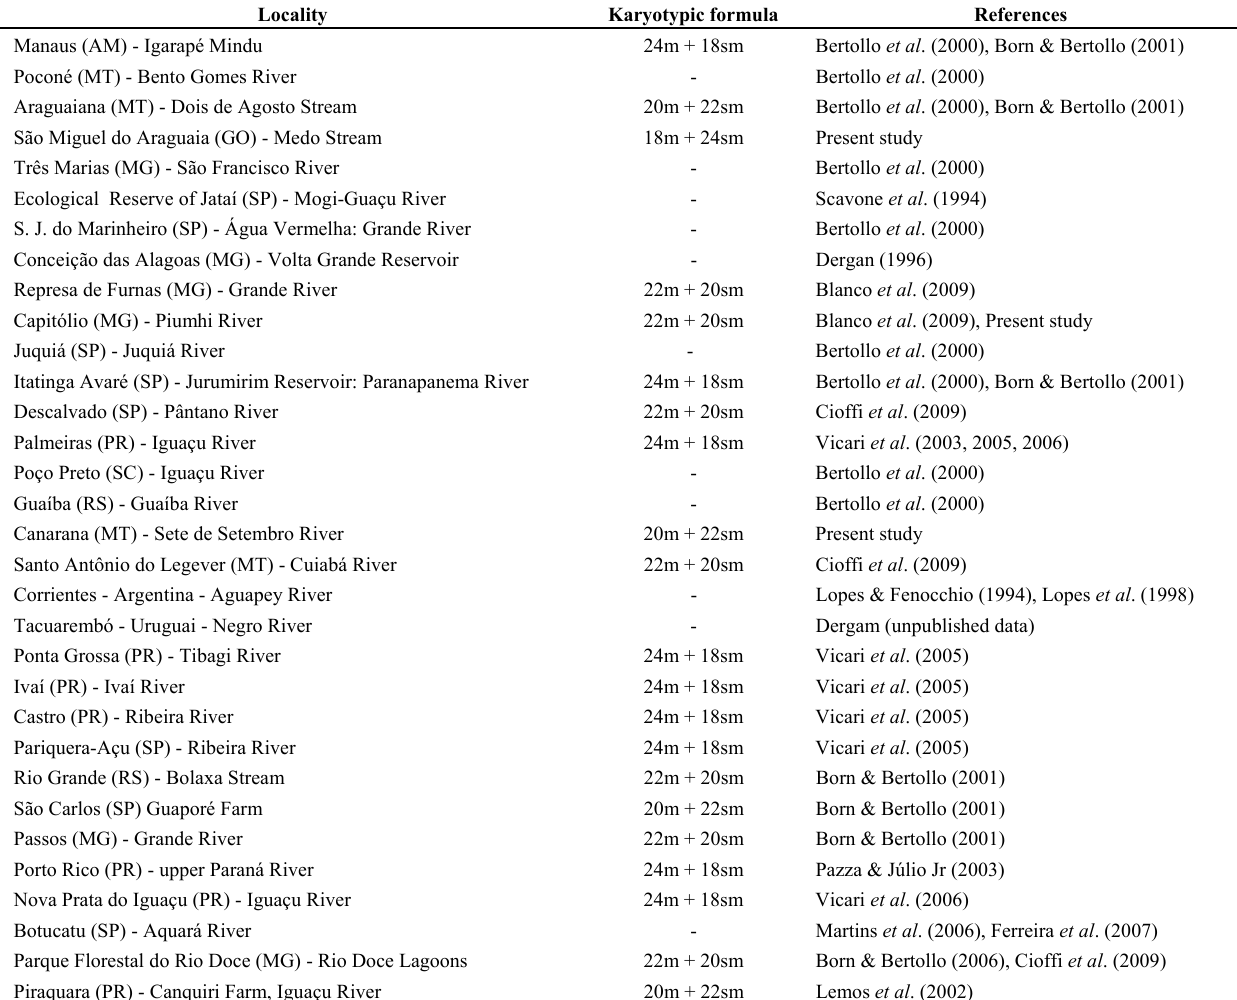
Table 1. Review of the cytogenetic studies of different populations of karyomorph A of the Hoplias malabaricus .